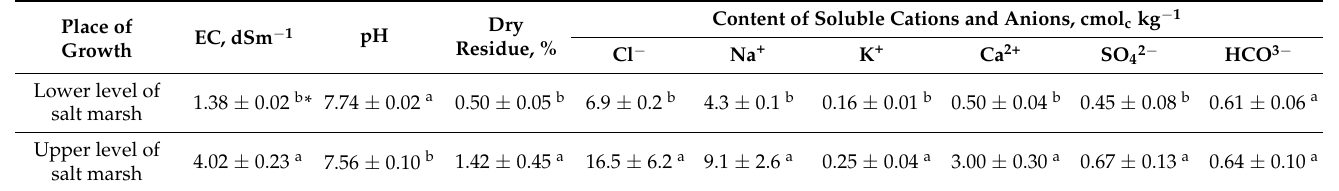
Table 1. The results of the chemical analysis of soil of two habitats of the studied plant species. Content of Soluble Cations and Anions, cmol c kg − 1 Dry Place of EC, dSm − 1 pH Residue, % Growth Cl − Na + K + Ca 2+ SO 42 − HCO 3